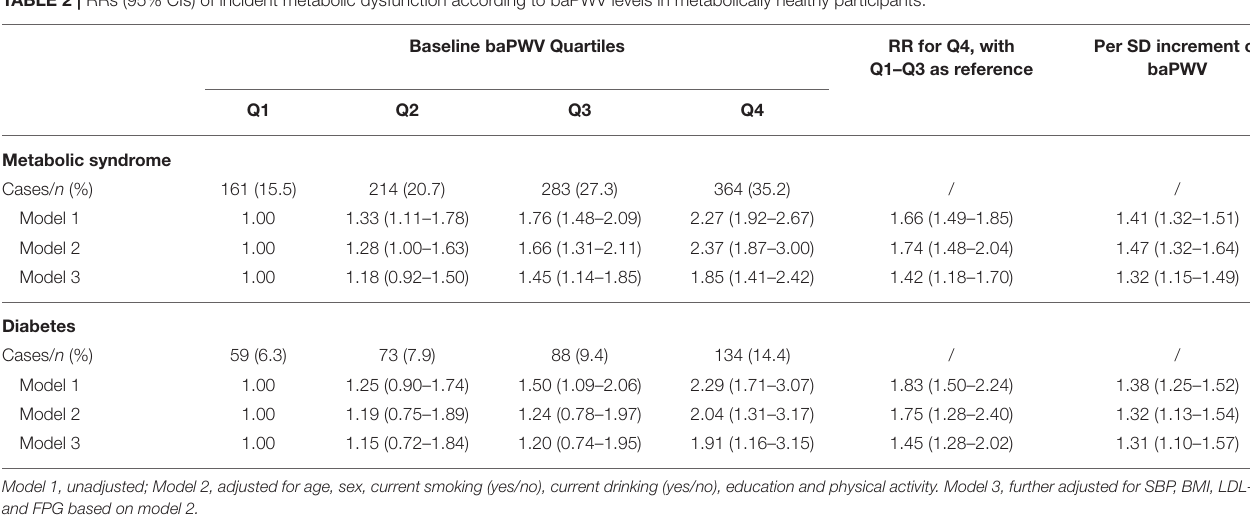
TABLE 2 | RRs (95% CIs) of incident metabolic dysfunction according to baPWV levels in metabolically healthy participants.